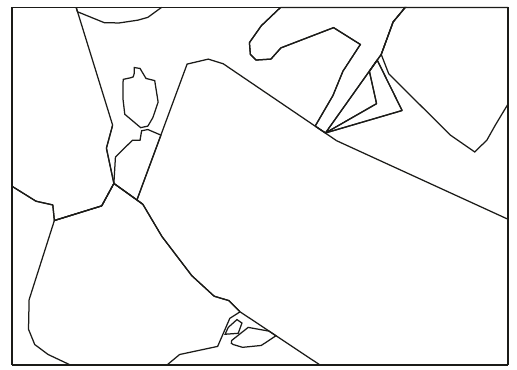
Figure 5: The boundary lines for each composition in the kernstone.